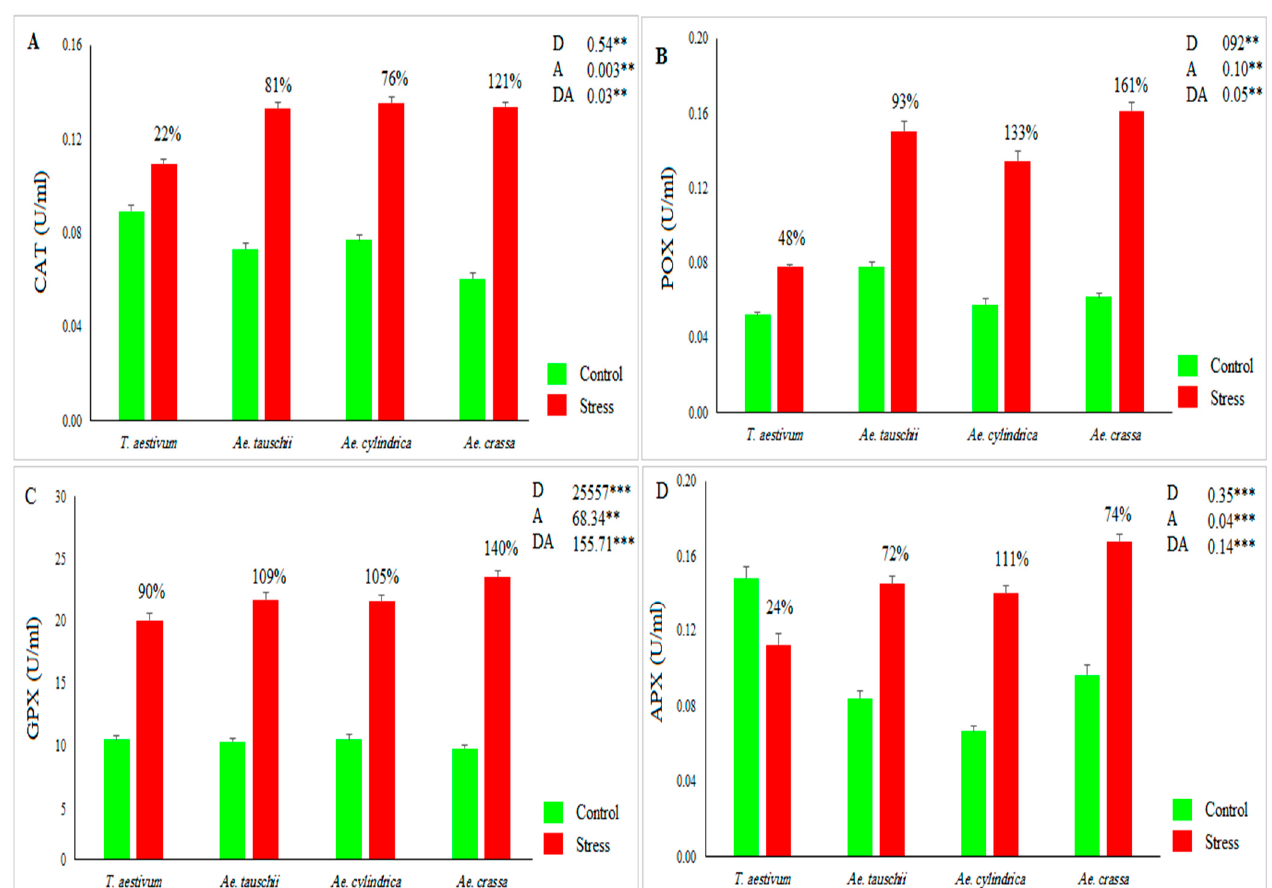
Figure 1. Mean values for ( A ) CAT activity, ( B ) POX activity, ( C ) GPX activity, and ( D ) APX activity across 186 investigated accessions under the control and drought stress conditions. D, A, and DA indicate drought treatment, accessions, and their interaction effects, respectively. ** and *** indicate significance at p < 0.01 and p < 0.001, respectively.